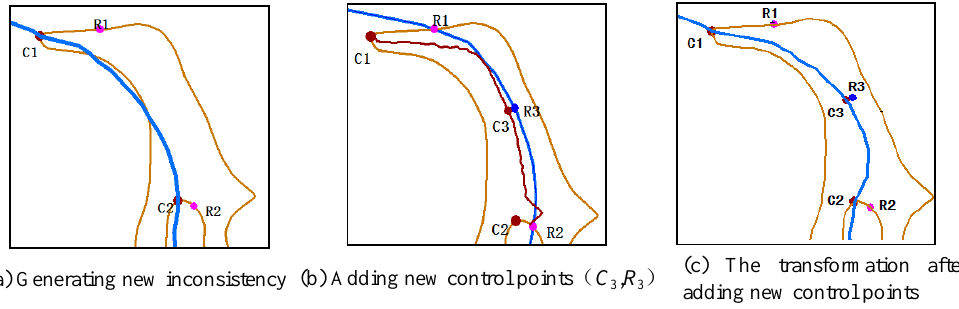
Figure 7. Adding new control points to avoid new inconsistency after river network